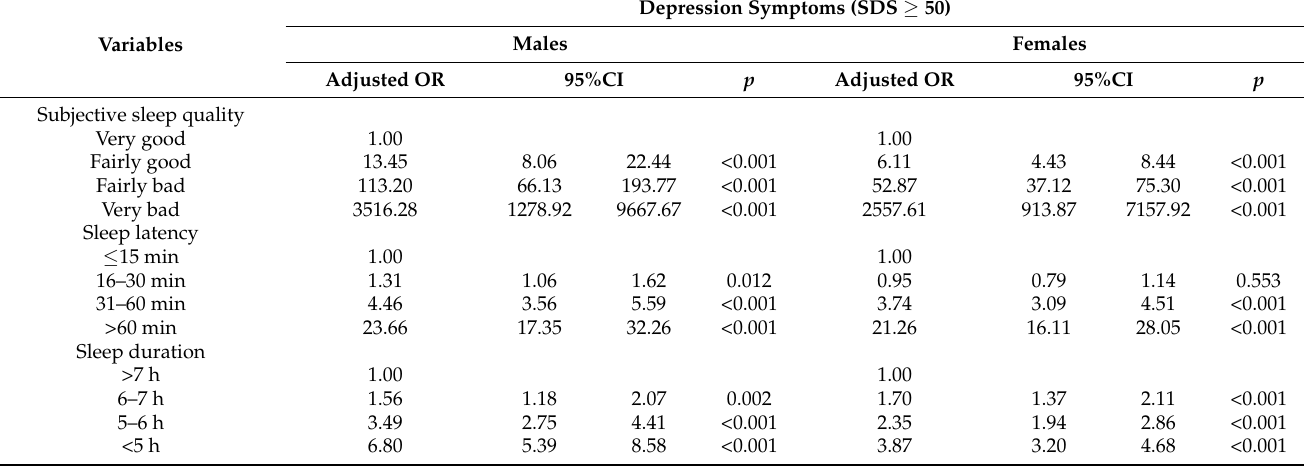
Table 3. The relationship between different factors of the PSQI and depressive symptoms by